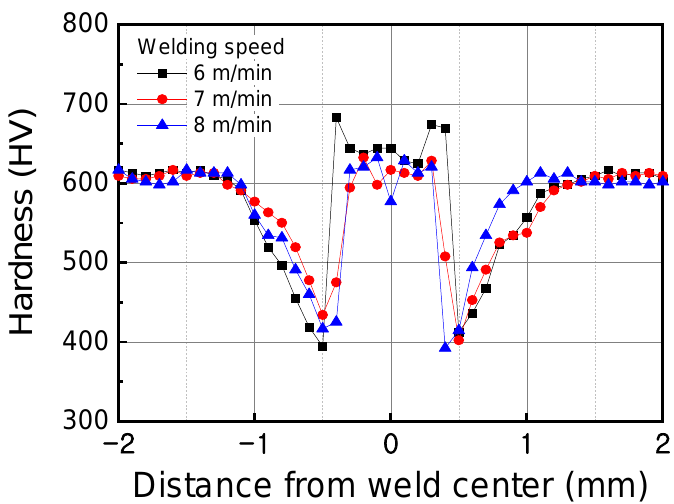
Figure 7. Vickers hardness profiles of bead-on-plate welds corresponding to welding speed.